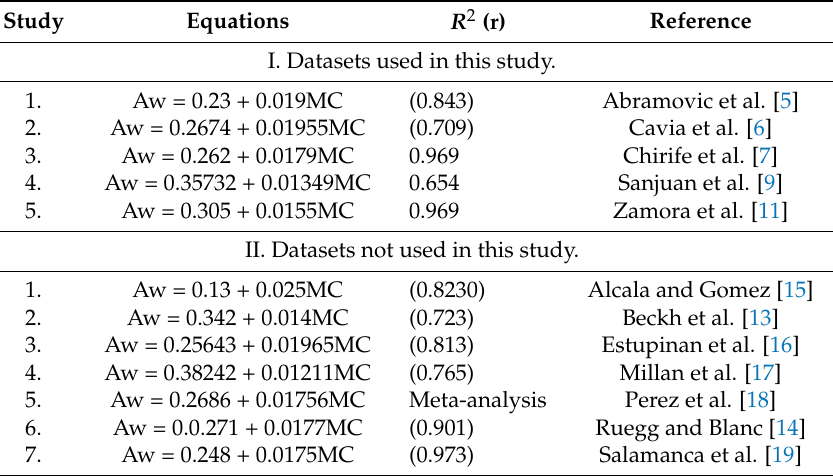
Table 2. Published equations of water activity and moisture content of